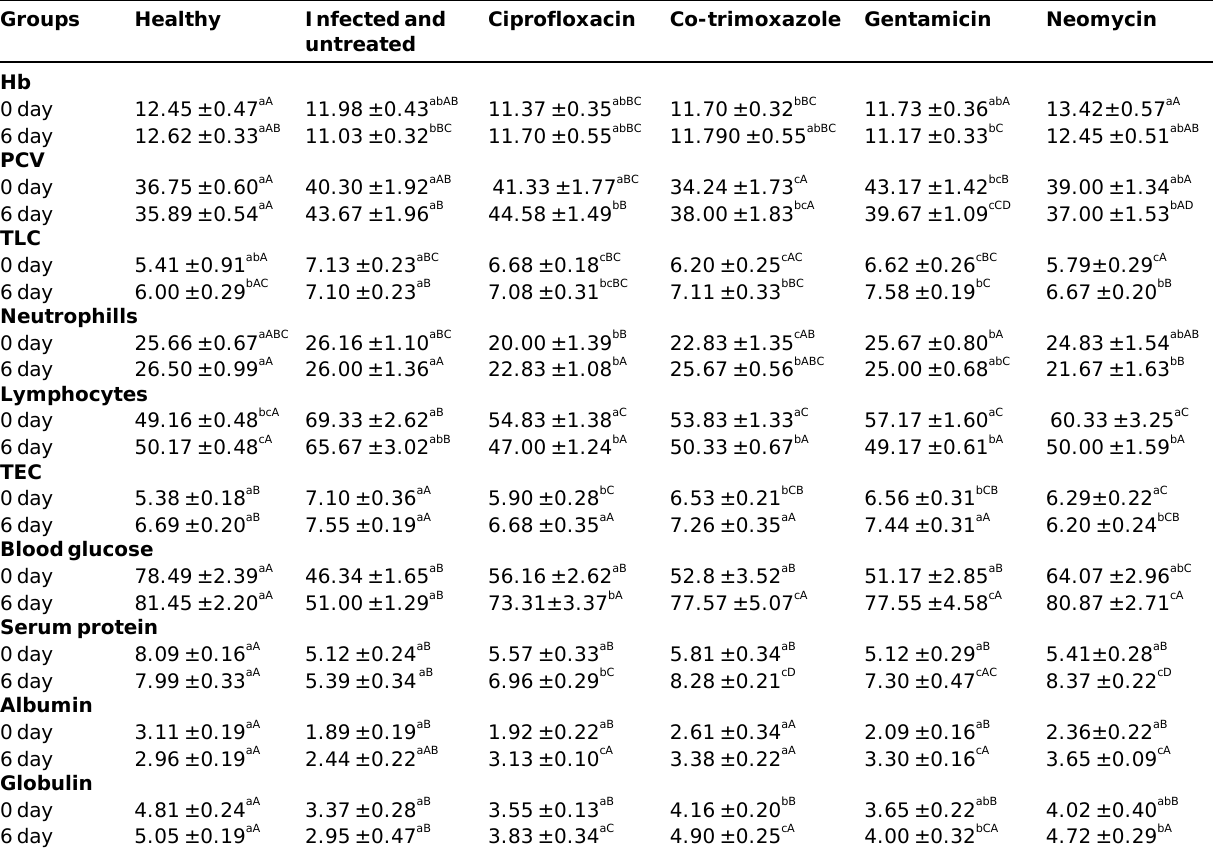
Table-1. Hematobiochemical values (Mean ± SE) before and after treatment